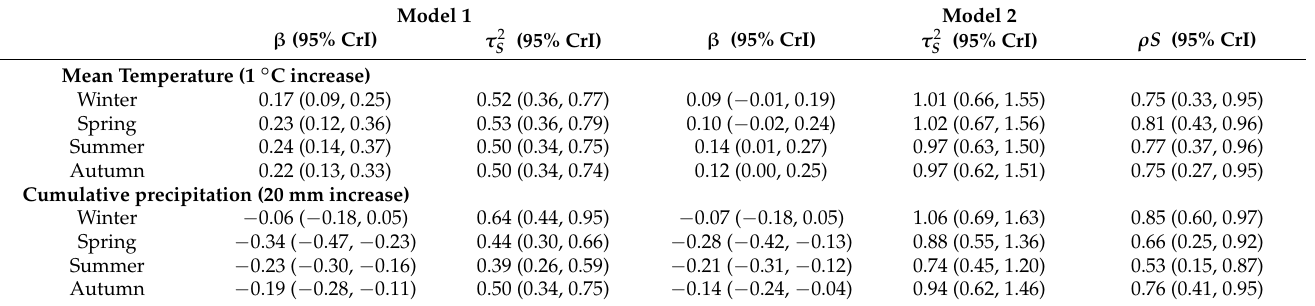
Model1: estimates adjusted for NDVI, roughness and HIV hospital admissions obtained from the Leroux model with ρ S = 0 (independent random effect); Model2: estimates adjusted for NDVI, roughness and HIV hospital admissions obtained from the full Leroux model with ρ S left free (spatially correlated random effects). ρ S : median values for beta coefficients referred to a unit increase in the climatic parameter (1 ◦ C for temperatures and 20 mm